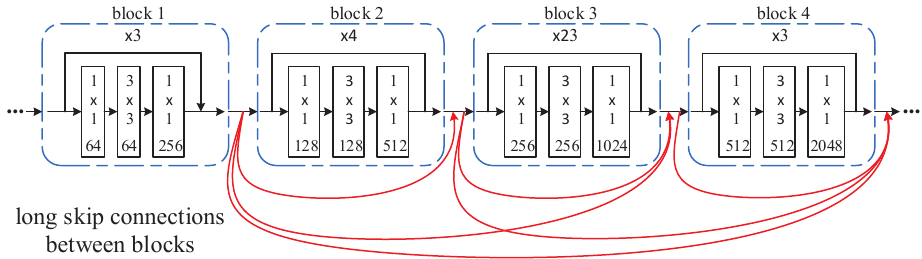
Figure 6. Long skip connections between blocks (red